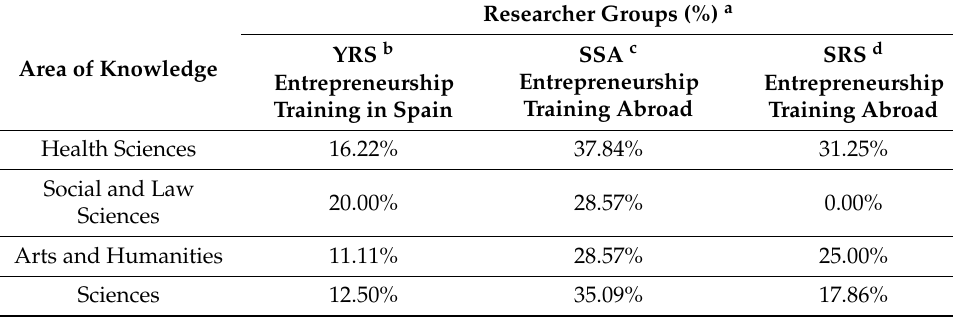
Table 2. Entrepreneurship